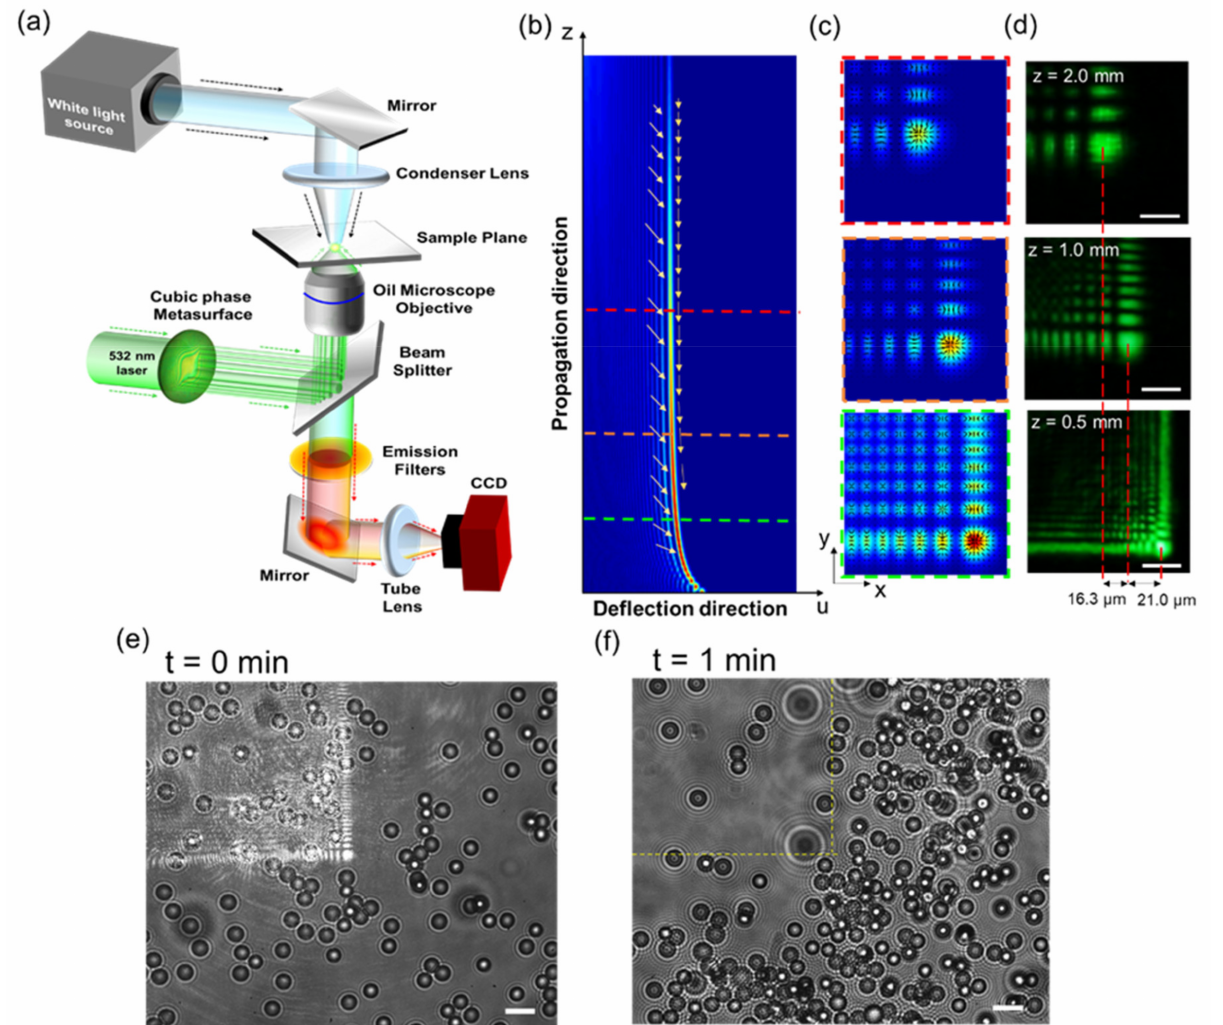
Figure 4. Experimental demonstration of 3D optical manipulation. ( a ) Experimental configuration of optical manipulation by the vertically accelerated 2D Airy beam, generated by a cubic-phase metasurface. Numerically calculated intensity gradient distribution of a vertically accelerated 2D Airy beam. ( b ) Along the longitudinal ( u-z ) plane, the yellow arrows represent the predicted motions of guided particles. ( c ) Along the transverse ( x-y ) planes at the different propagation depths, the black arrows indicate the magnitude and direction of the intensity gradient. ( d ) The experimental intensity results of the shifted main lobe of the beams are at z = 0.5 mm, z = 1.0 mm, and z = 2.0 mm, respectively. Scale bar: 25 µ m. The distribution of 3 µ m microspheres suspended in water solution, ( e ) before and ( f ) after illuminated with the focused beam. Scale bar: 6 µ m. The yellow dash lines highlight the illuminated location of the